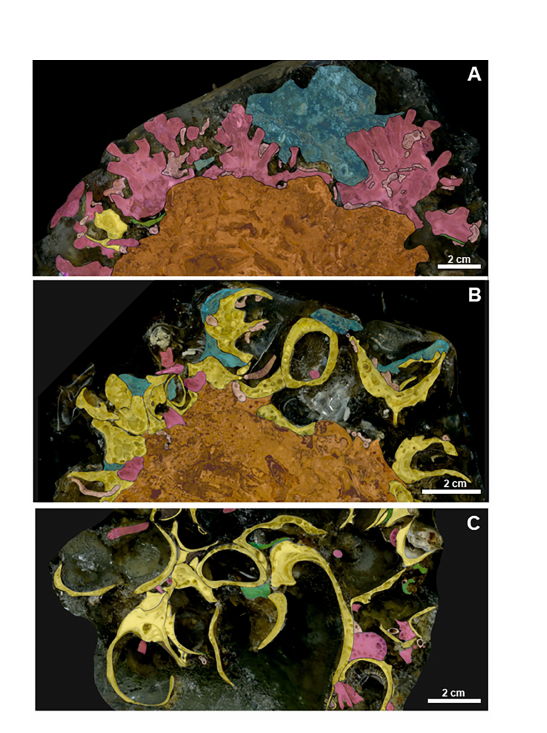
FIGURE 4 HD digitized images of impregnated sample slices of the bioconstructions. Scale bar = 2 cm. Legend: yellow = bivalves; violet = scleractinians; blue = sponges; green = bryozoans; pink = serpulids; and orange = biogenic substrate. (A) SFC bioconstruction shows a compact, moderately porous framework. It is made up of scleractinians growing on a pre- existing biogenic substrate. (B) At OTR, the bioconstruction is made up of closed shells of N. cochlear laying on a previous biogenic structure. (C) SML. The bioconstruction frequently shows disarticulated mollusk valves that are deeply bored by